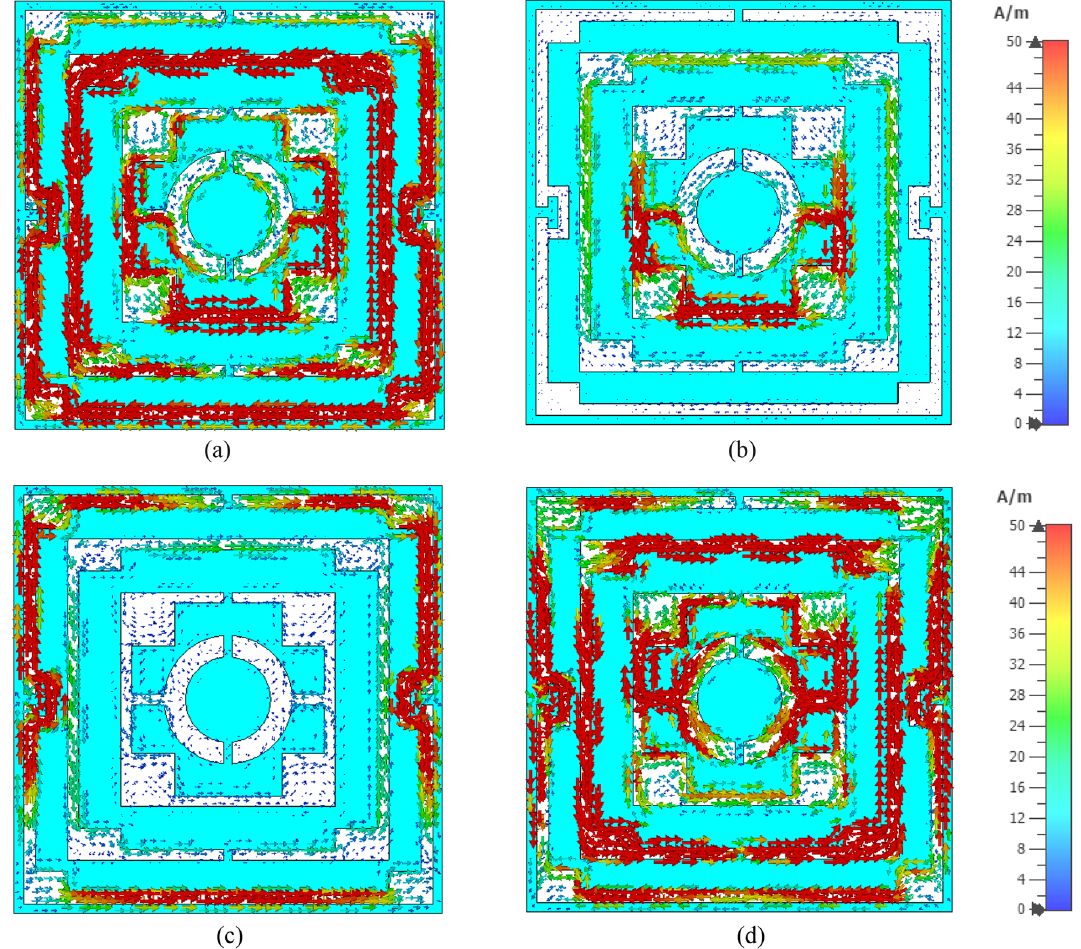
Figure 17. Surface current distribution at absorber resonator ( a ) 3.98 GHz ( b ) 5.5 GHz ( c ) 8.48 GHz and ( d ) 11.73